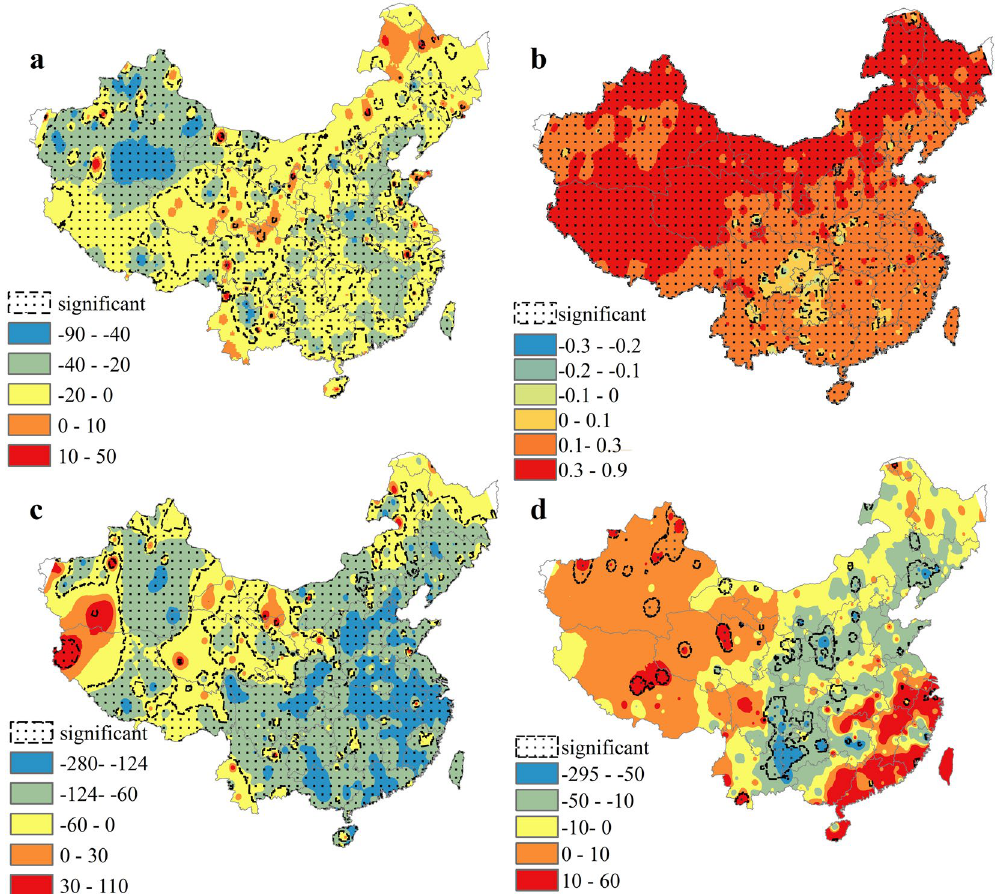
Figure 3. Trend of climatic factors in China from 1960 to 2013: ( a ) ET0, ( b ) temperature, ( c ) solar radiation, ( d ) precipitation. The legend indicates value of trend. The trend of climatic factors has different units: ET0 (mm/ decade), temperature (°C/decade), solar radiation (MJ/(m 2 d.decade)), precipitation (mm/decade). The map was generated by the software ArcGIS 10 81